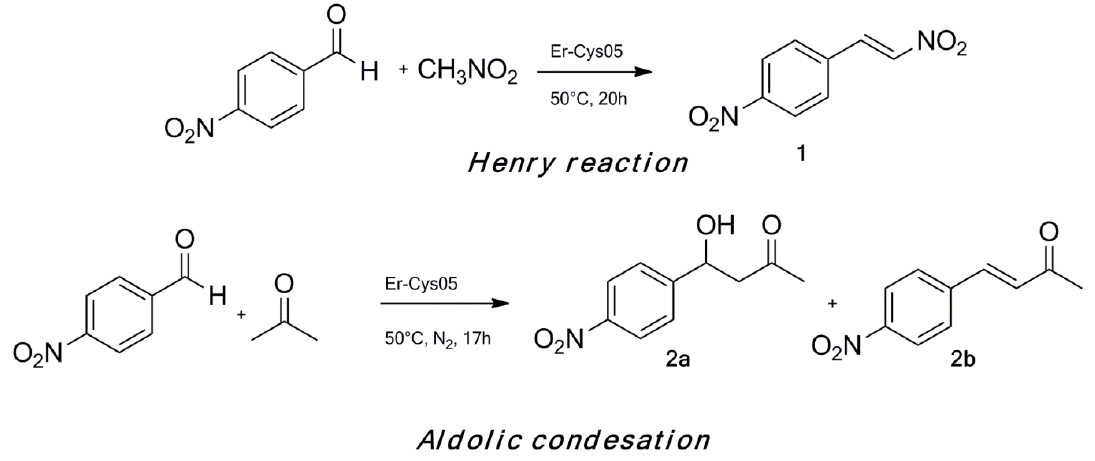
Scheme 2. General synthetic scheme for Henry reaction and aldol